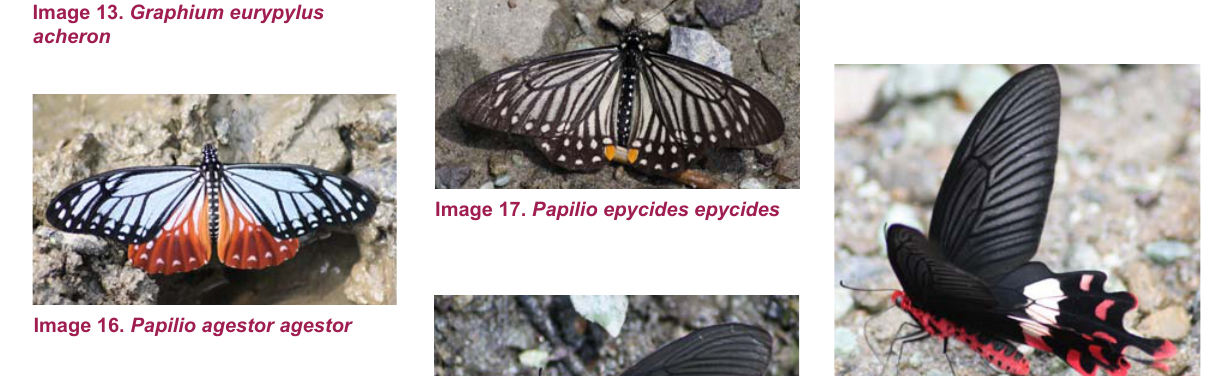
Image 15. Graphium xenocles xenocles